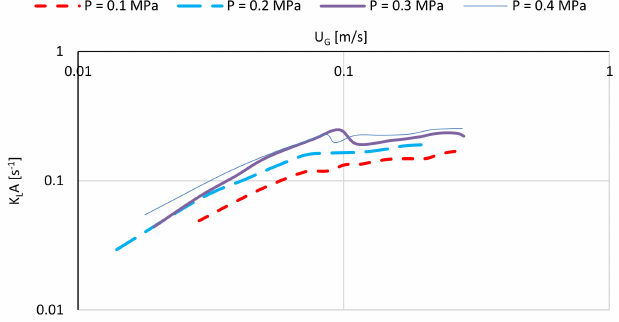
Figure 33. Influence of the operating pressure on k L a —data from Letzel et al.